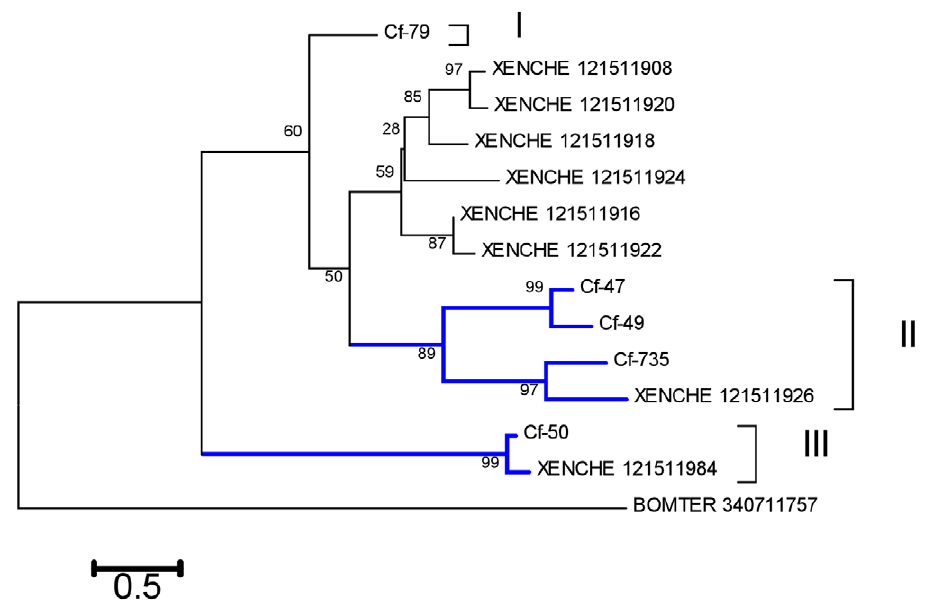
Figure 2. Phylogram of the flea salivary phosphatase family with one sequence from Bombusterrestris as an outgroup. The sequences were aligned by ClustalW. The Ctenocephalides felis sequences are recognized by starting with Cf- and are followed by the number of the contig from which they derived. The other sequences were obtained from GenBank and are recognized by the first three letters of their genus name, followed by the first three letters of the species name, followed by the NCBI accession number. The numbers at the nodes represent the percent bootstrap support (10,000 iterations) for the neighbor-joining algorithm, using pairwise deletion and gamma distribution of the amino acid substitutions. The bar at the bottom indicates the amino acid substitution rate per site. The Roman numerals indicate tree locations for the cat flea sequences that are distant enough to be from different genes. Clade II may have two genes, for a total of four possible genes.